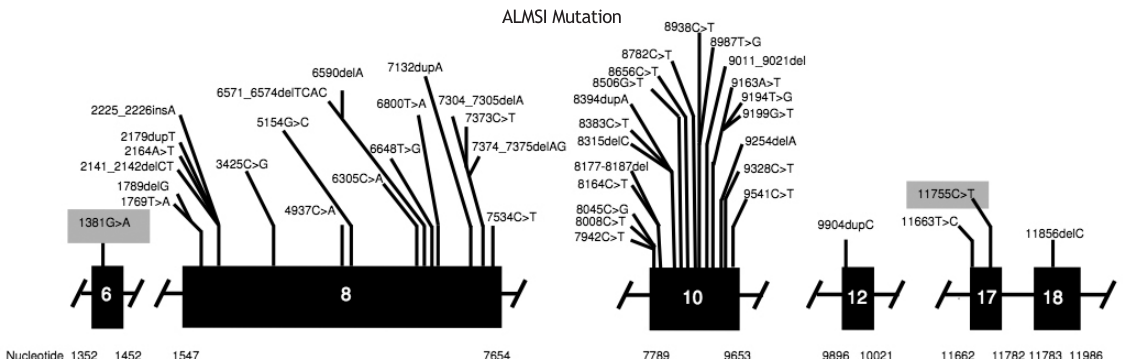
Figure 2 Mutation in the ALMS1